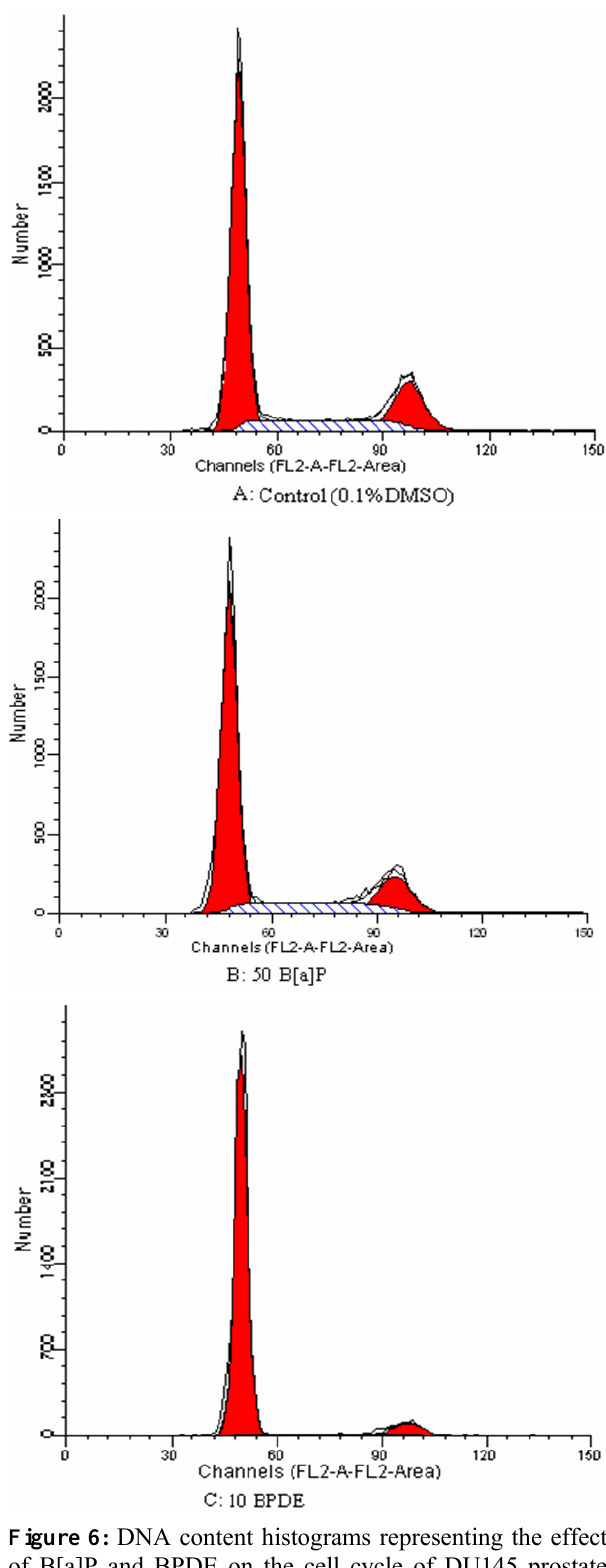
Figure 6: DNA content histograms representing the effect of B[a]P and BPDE on the cell cycle of DU145 prostate carcinoma cells. DU145 cells were incubated with B[a]P and BPDE for 48 hours. (A) Control (0.1% DMSO), (B) 50uM B[a]P treated cells, and (C) 10uM BPDE treated